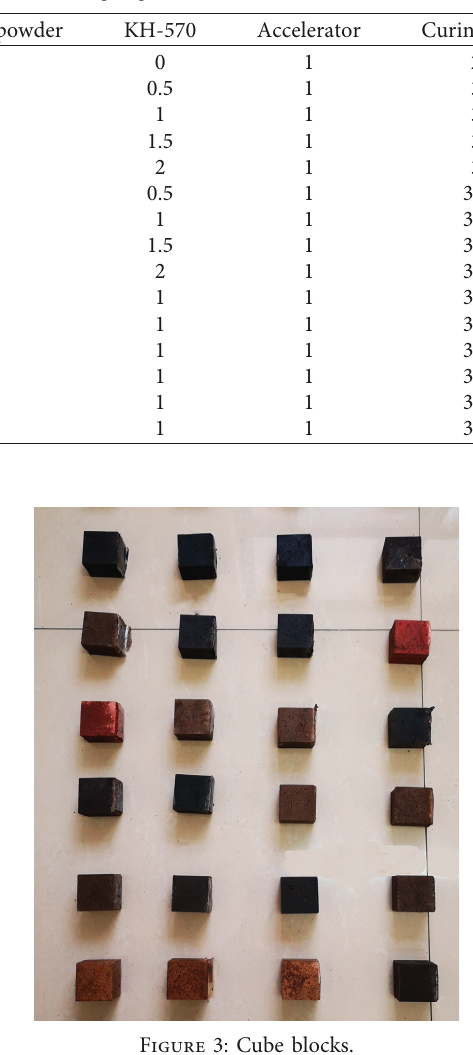
Table 4: Test proportion of new resin anchorage agent.